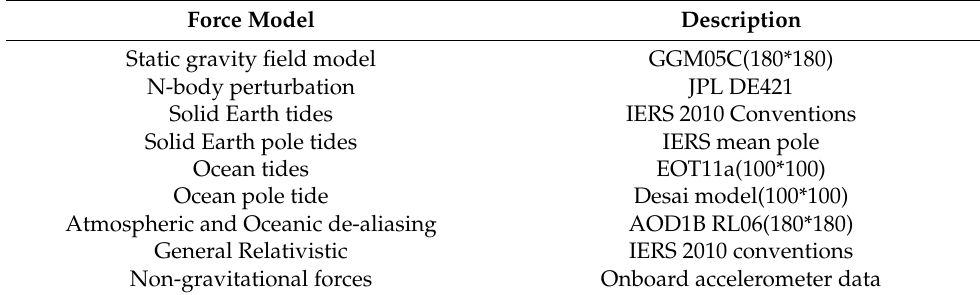
Table 1. Perturbation